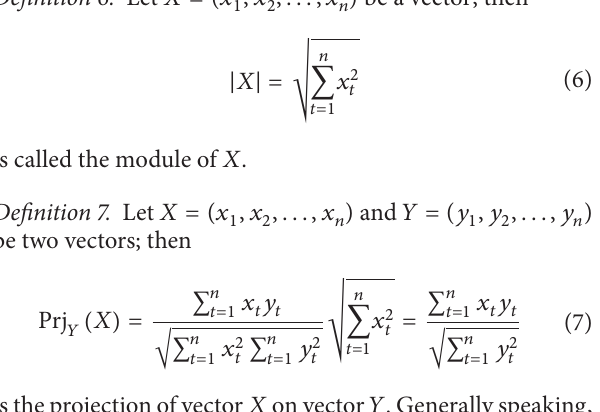
method [14] such as cosine value and projection